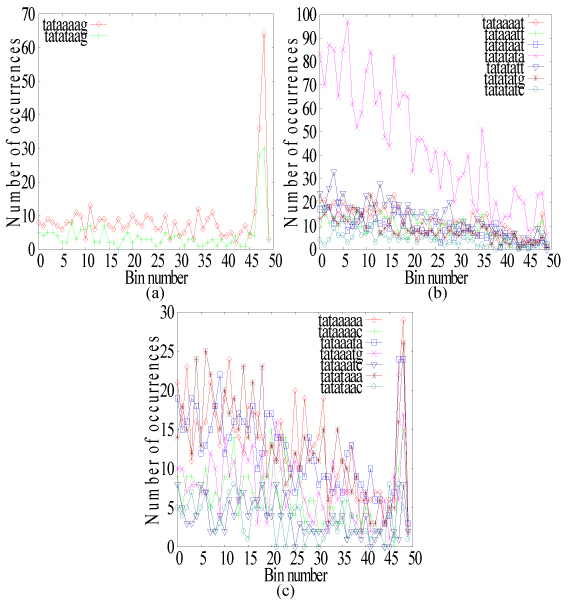
Three patterns of frequency distribution of TATA elements on the data set S1000. Sixteen TATA elements are classified into three frequency patterns: (a)Peak pattern: including two TATA elements(TATAAAAG and TATATAAG) which show very high abundance at the location close to TSSs, but do not show any abundance at other locations; (b)Bottom pattern: including seven TATA elements which show decreasing abundance from 5' end of promoters to TSSs; (c)Bottom-peak pattern: including seven TATA elements which show decreasing abundance from 5'end of promoters to near TSSs, but there is strong abundance at the location close to TSSs which is higher than the other locations.